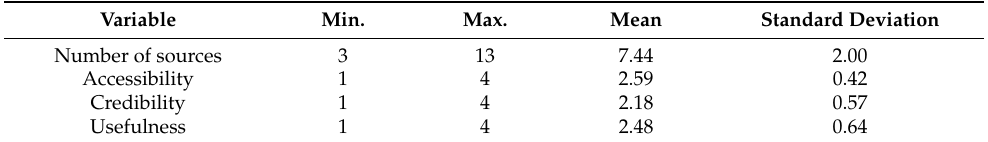
Table 3. Descriptive statistics for four variables used in farmers’ information-seeking behavior clusters.